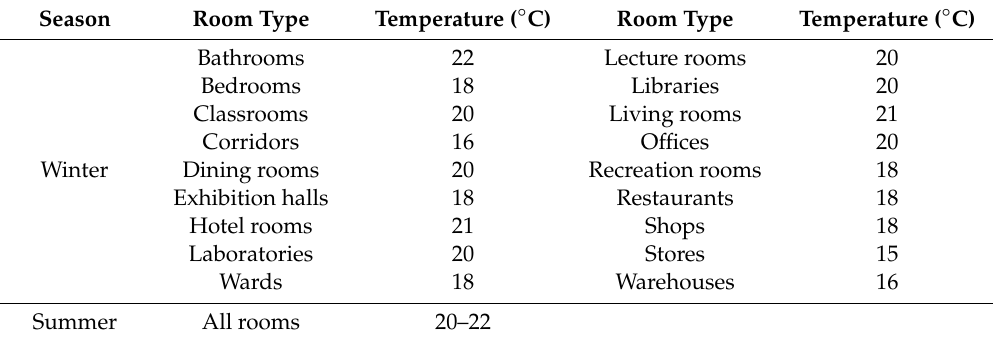
Table 5. The minimum acceptable room temperature in the winter and the optimal room temperature in the summer of di ff erent room types [49].